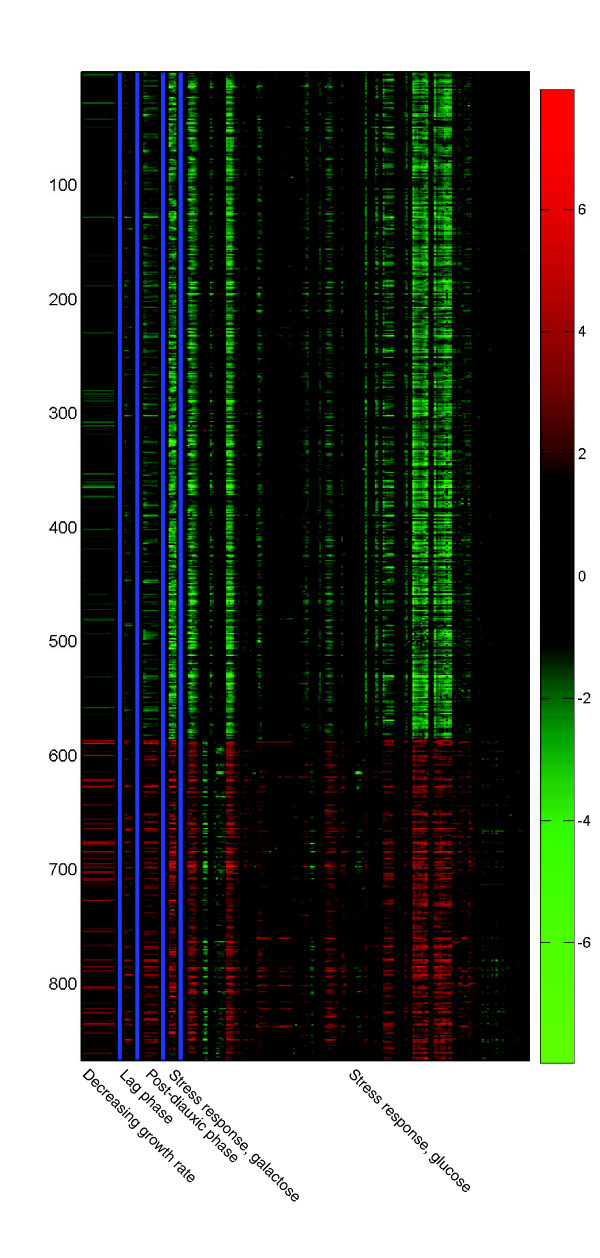
Comparison between conditions with changes in growth rate. From left to right separated by blue, vertical lines: the fold change in transcript levels between cells grown at lowest (average of μ = 0.02 and 0.05 per hour) and the highest growth rate (average of 0.33 per hour); cells in lag phase (four time points: 0, 0.01, 0.05, and 0.1 hours [5]); cells in postdiauxic phase (eight time points: 36, 51, 62, 83, 107, 130, 178, and 212.25 hours [5]); stress response, galactose (four time points: 20, 40, 60, and 140 min [6]); and ESR transcript profiles (right of blue vertical line) and 13 stress condition obtained from the work by Brown and coworkers (Figure 3 in their report [7]). The approximately 900 ESR genes were originally identified by hierarchical clustering of all yeast transcripts from 142 microarray experiments [7]. The transcripts formed two distinct clusters of transcript that responded similarly to 13 stress condition, and the corresponding genes were denoted the ESR genes [7]. Transcript levels from all conditions are based on a global normalization of the DNA arrays, in which it is assumed that the cellular mRNA levels remain constant in response to stress or changes in the specific growth rate (also see Additional data file 5). ESR, environmental stress response.